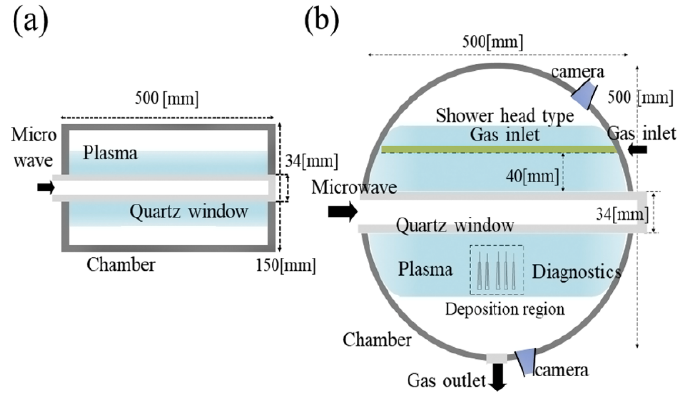
Figure 4. Front ( a ) and top ( b ) views of the experimental and diagnostic setup diagram.